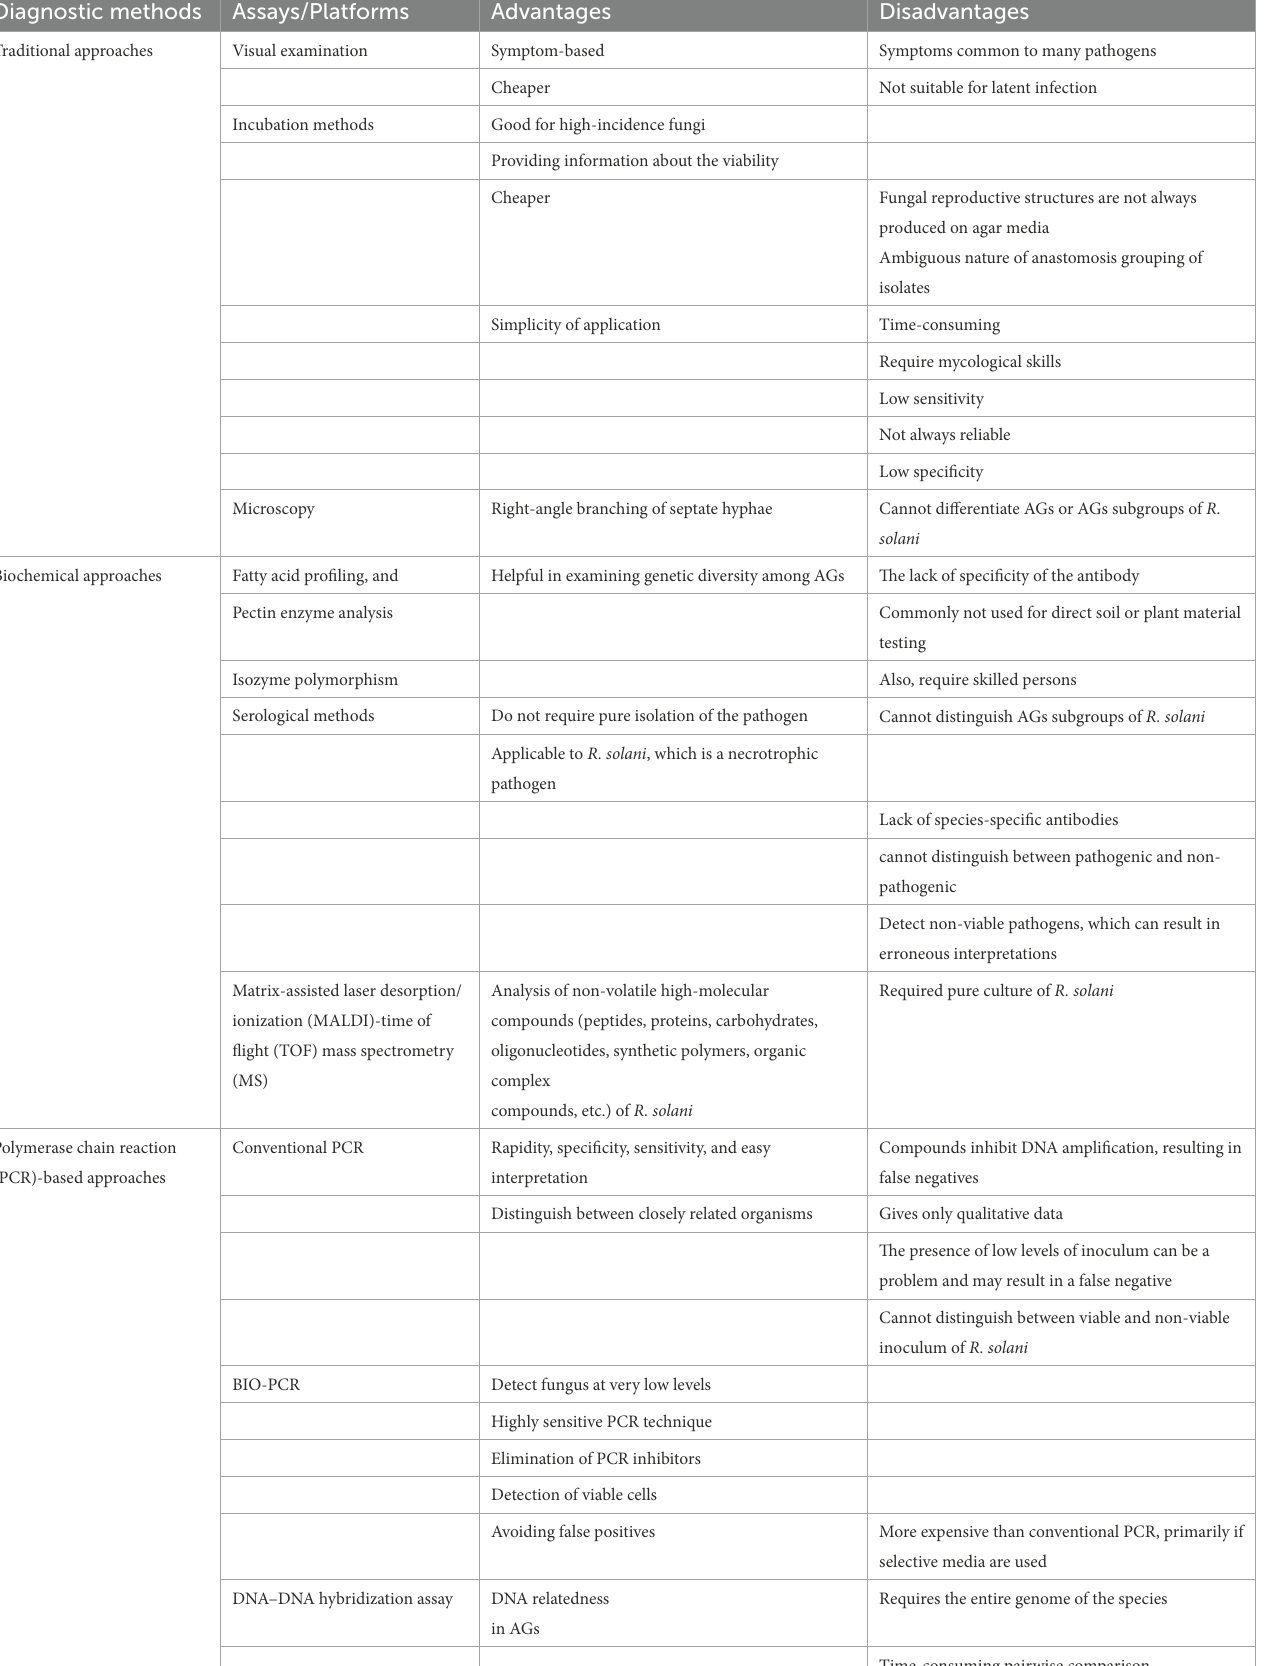
TABLE 2 Advantages and disadvantages of different detection and diagnostic approaches for R. solani associated with legume